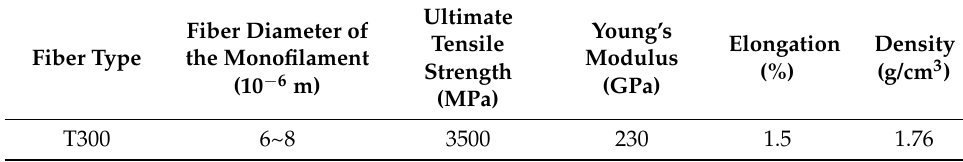
Table 1. Physical properties of T300 carbon fibers.